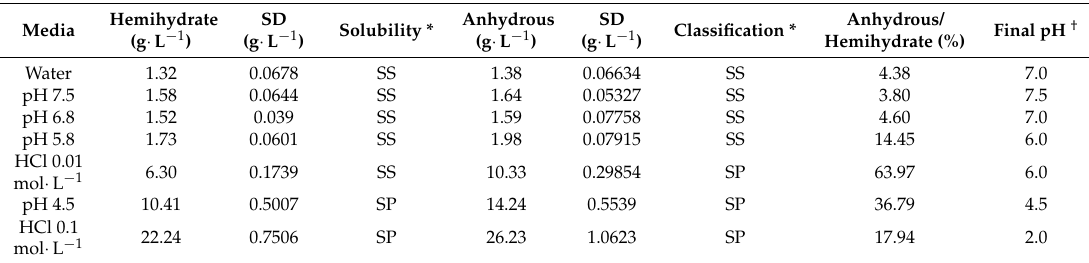
* Legend: SS = slightly soluble; SP = sparingly soluble. Source: The United States Pharmacopeia, 38 ed., 2015; † The final pH was invariant considering the two solids forms in a same media.